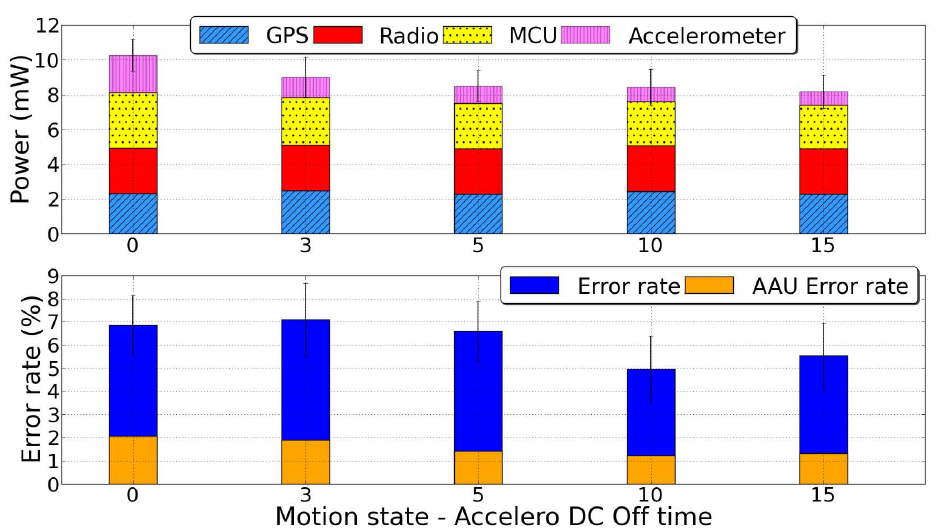
Figure 12. The effect of varying the minimum stationary time T S accelerometer yields the lowest error rates and power